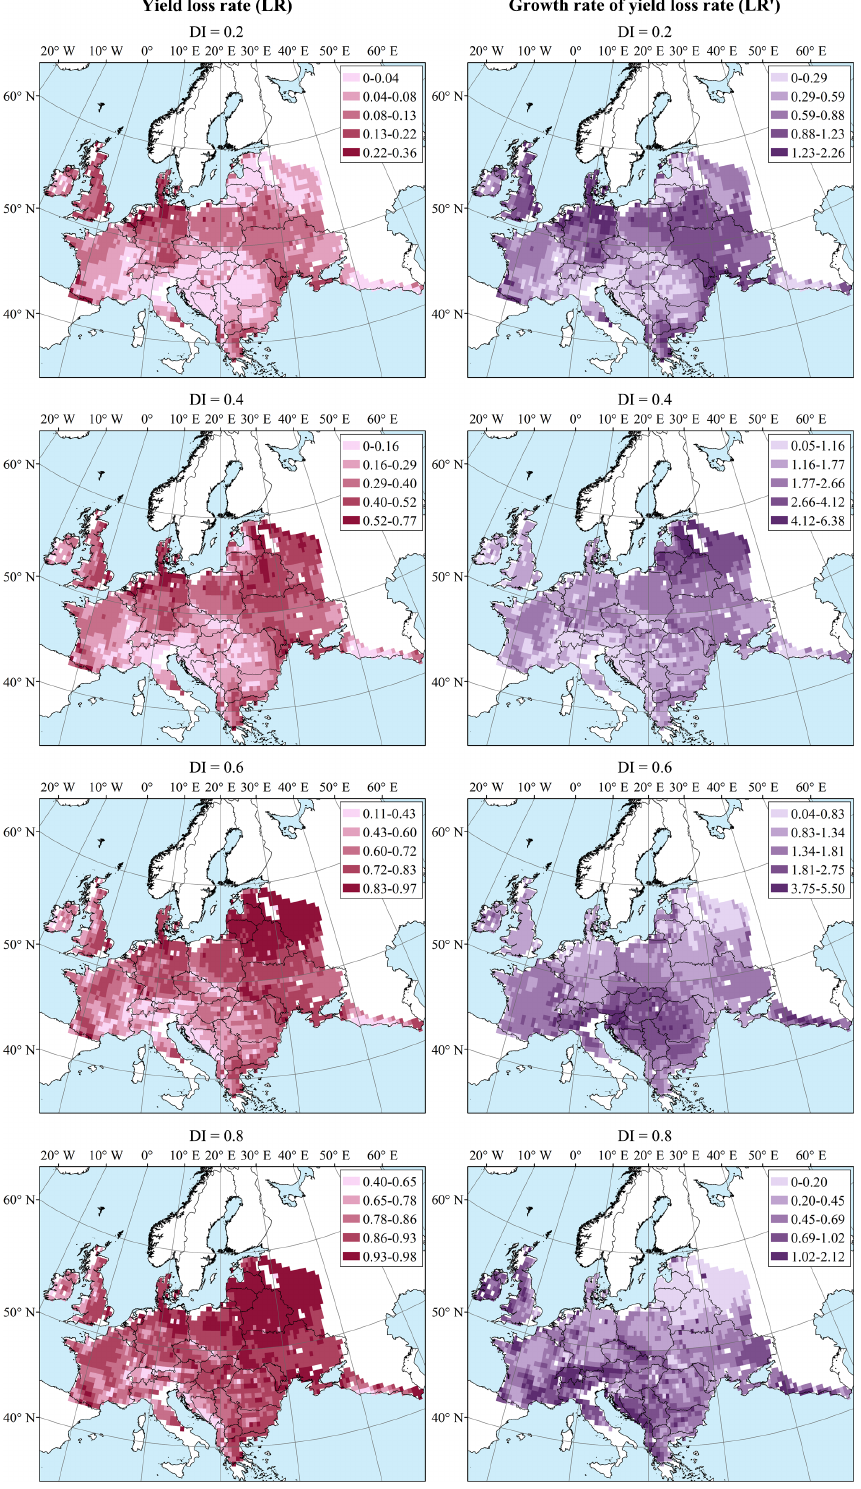
Figure A1. Spatial distribution of yield loss rate and loss rate growth rate under different drought